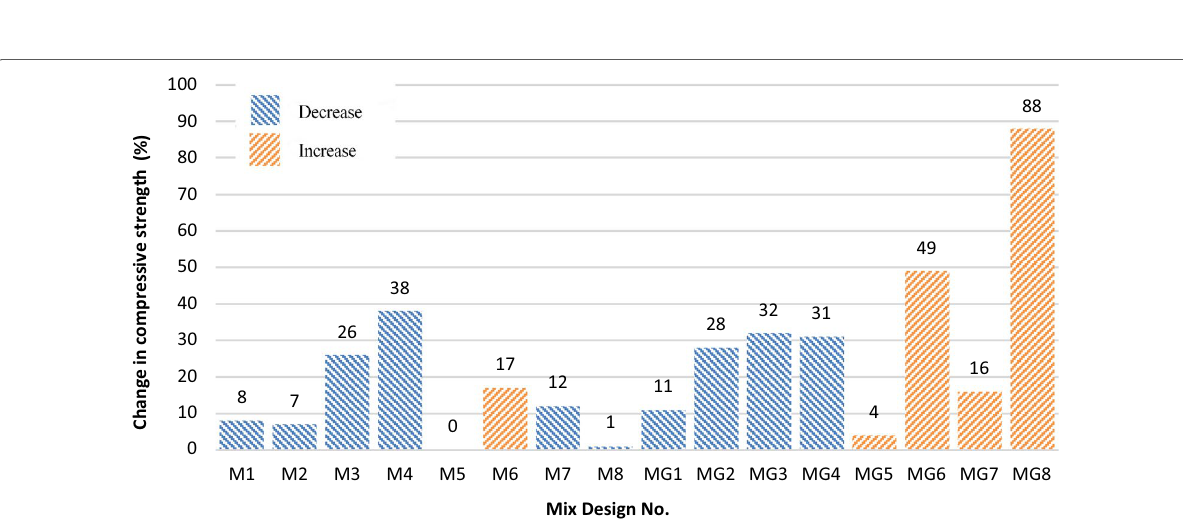
Fig. 15 Effects of GW on the residual compressive strength after